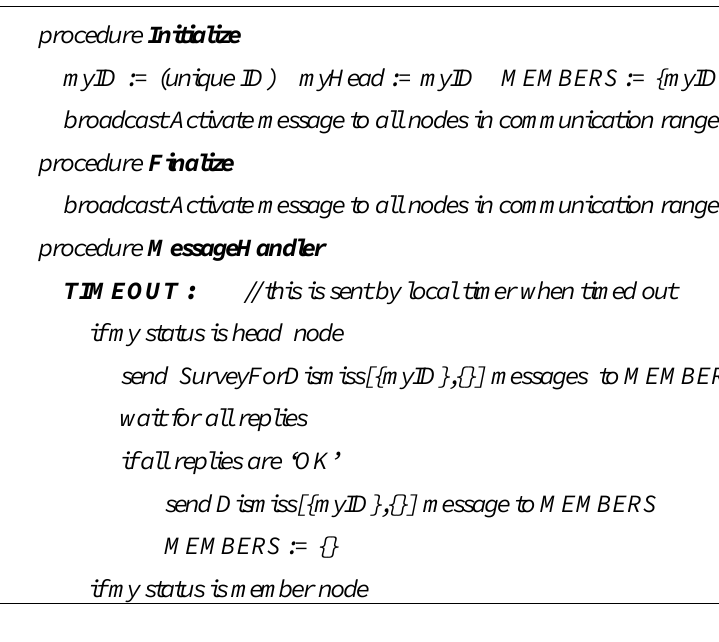
Table 2. Pseudo codes of optimization processes at each